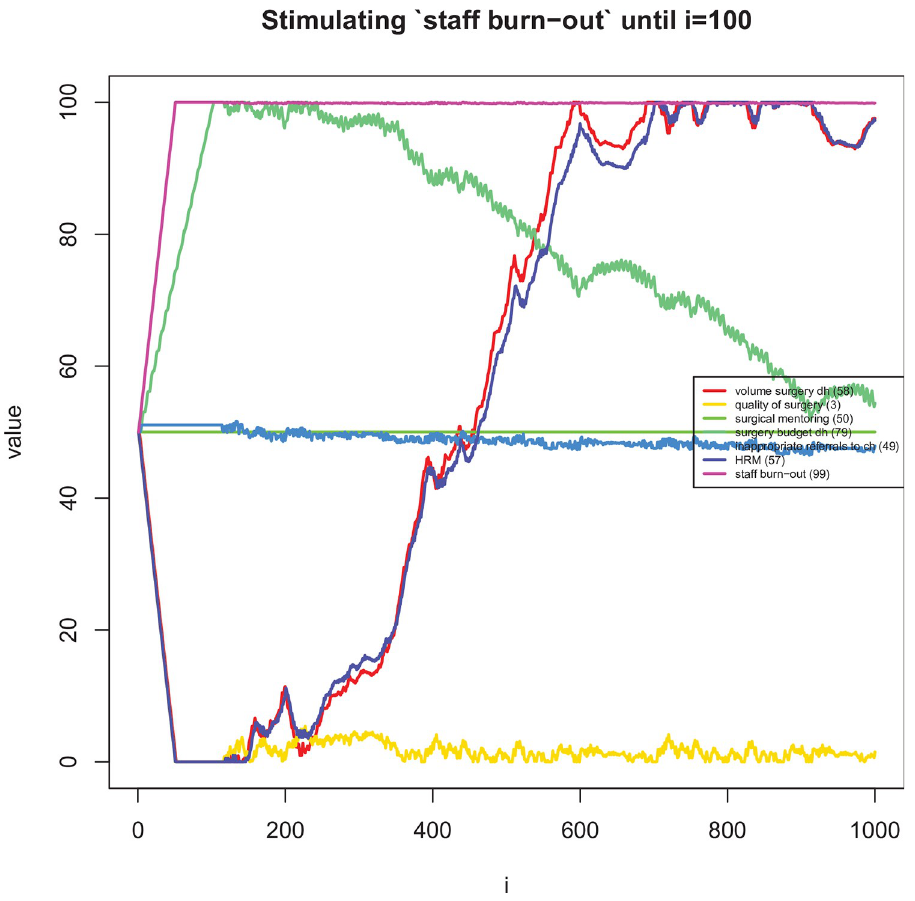
Fig 9. Long term dynamic explorations of the effects on changes in ‘staff burn-out’ for the first 100 time periods.